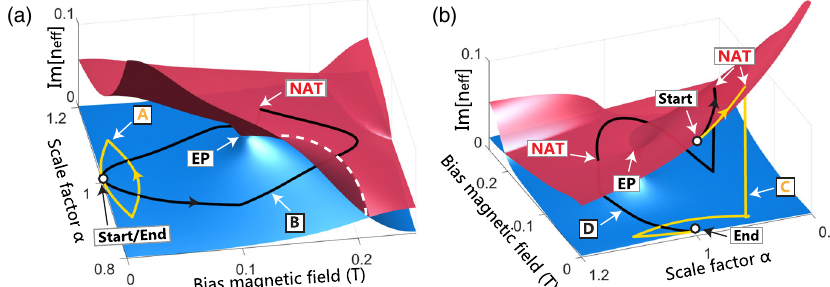
FIG. 7. (a) Calculated imaginary part of the effective mode index as a function of the bias field and scale factor of the system at 11.5 GHz with structure parameters: W ¼ 8 mm, H ¼ 4 mm, g ¼ 0 . 5 mm, w ¼ 2 mm, and h ¼ 3 mm. The relative permittivity of the absorber is set to 4 þ 15 i . The yellow and black lines mark the state evolution trajectory for configurations A and B (see text for definition), respectively, and the white dashed line marks the branch cut. (b) Same as those in (a) except that the trajectories are for configurations C and